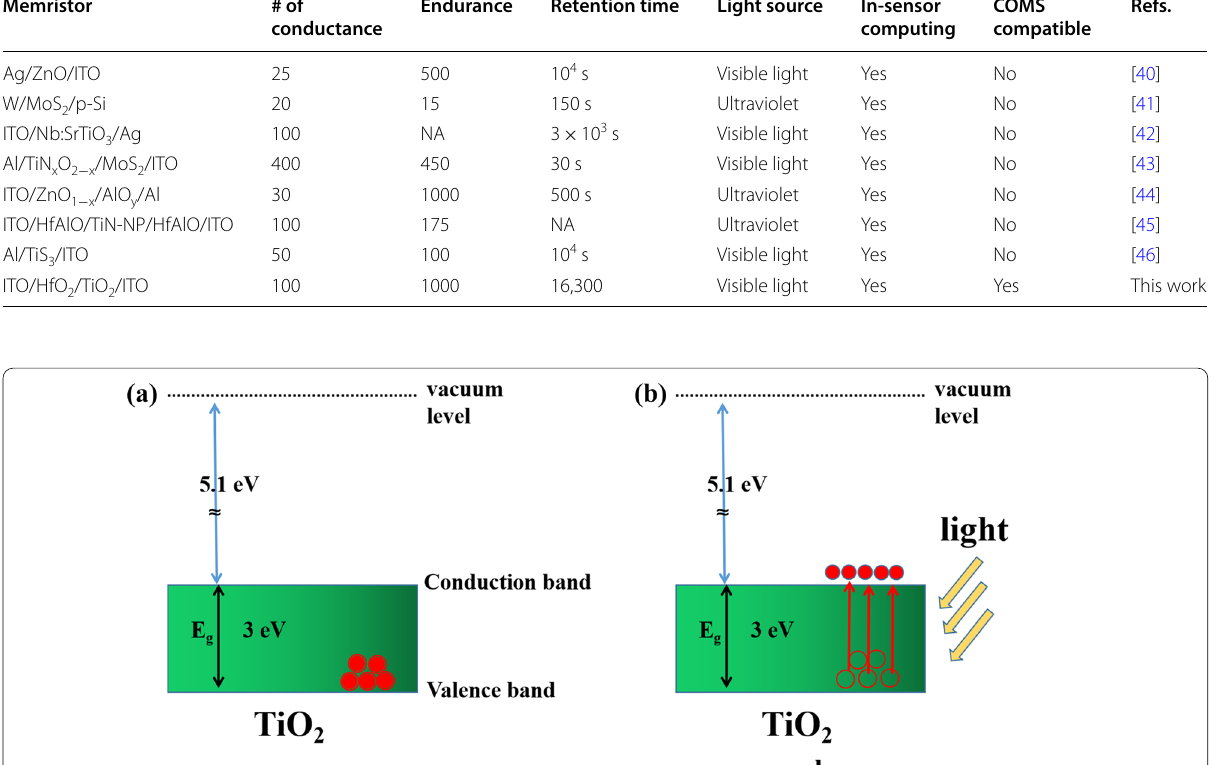
Table 1 Comparison between previous artificial photoelectronic memristive synapses and this work Memristor # of Endurance Retention time Light source conductance